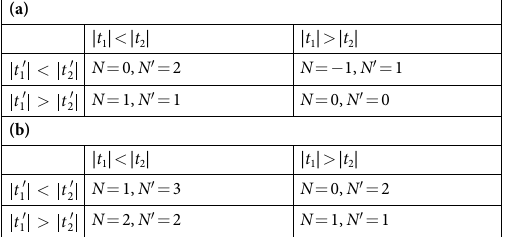
to Δ 1 , Δ 2 and map the gap of the system in the ( Δ 1 , Δ 2 ) plane. As 2 shown in Fig. 4(a), the white dot corresponding to the topological phase with N = 0, N ′ = 2 is adiabatically con-